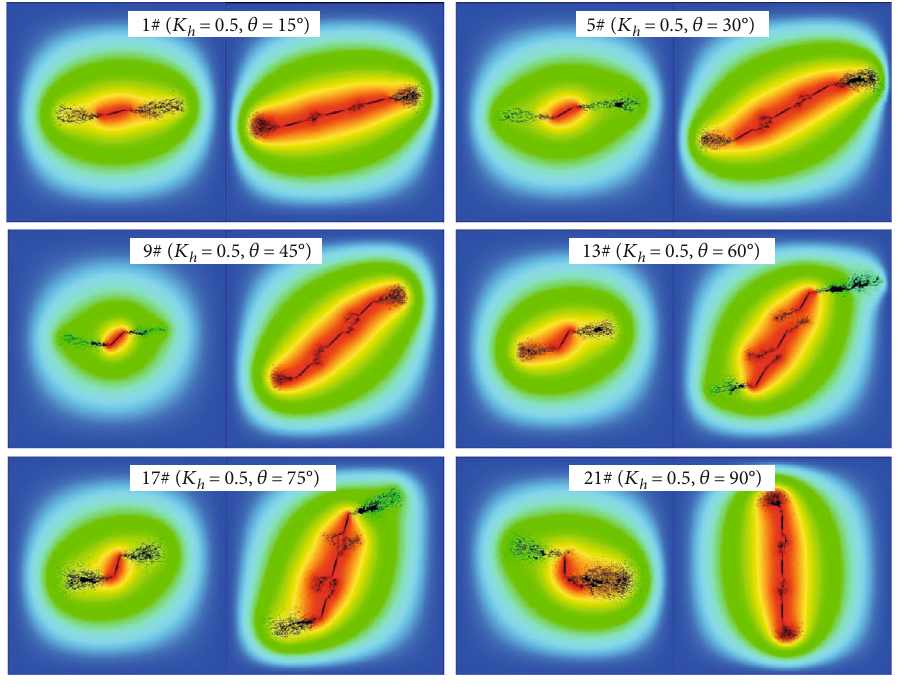
Figure 8: Crack propagation compared with a control group of simulations.